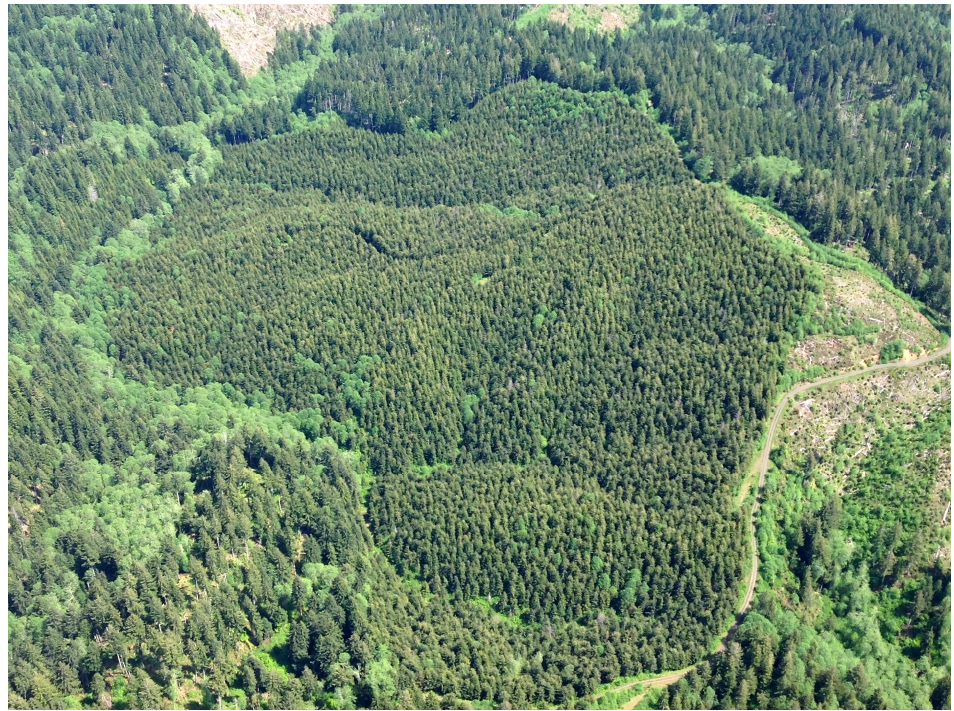
Figure 3. Mixed species stand with moderate SNC symptoms (yellowish foliage). Light green trees are hardwoods, mostly red alder, dark green trees are Sitka spruce and Western hemlock.